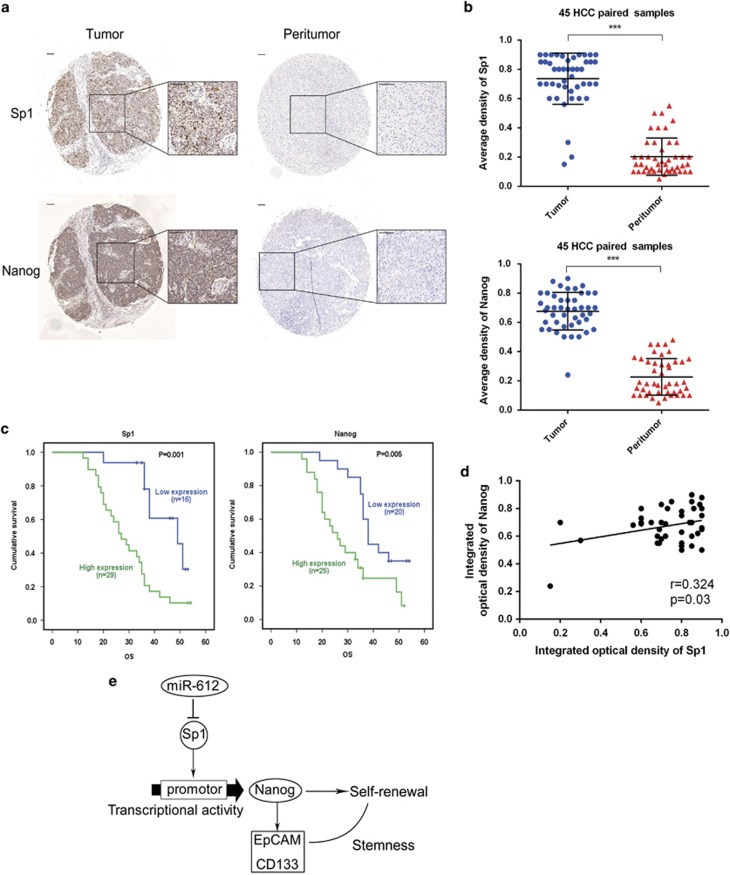
Clinical validation of Sp1 and Nanog in HCC patients. (a and b) Representative positive and negative Sp1 and Nanog expression in HCC tissues and their paired adjacent non-HCC tissues in immunohistochemistry. Bars: (left) magnification × 100, (right) magnification × 400. (c) Kaplan–Meier analysis of overall survival in HCC patients using SPSS 19.0. (d) Correlation analysis between Sp1 and Nanog. (e) Diagram of miR-612/Sp1/Nanog axis suppresses the stemness